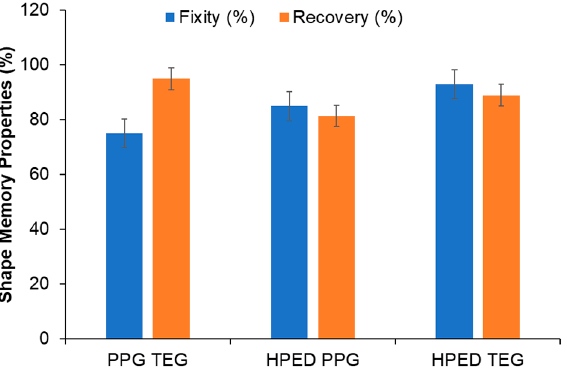
Figure 3. Shape memory properties are expressed in terms of shape fixity and recovery. Mean ± standard deviation displayed. n = 3. No statistical differences were observed between formulations.